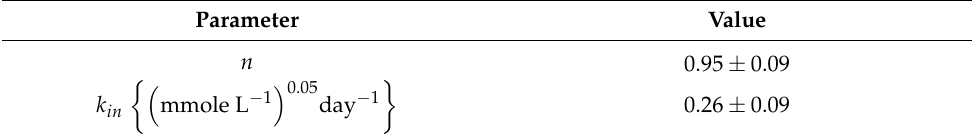
Table 2. Kinetic parameters for inorganic carbon consumption.